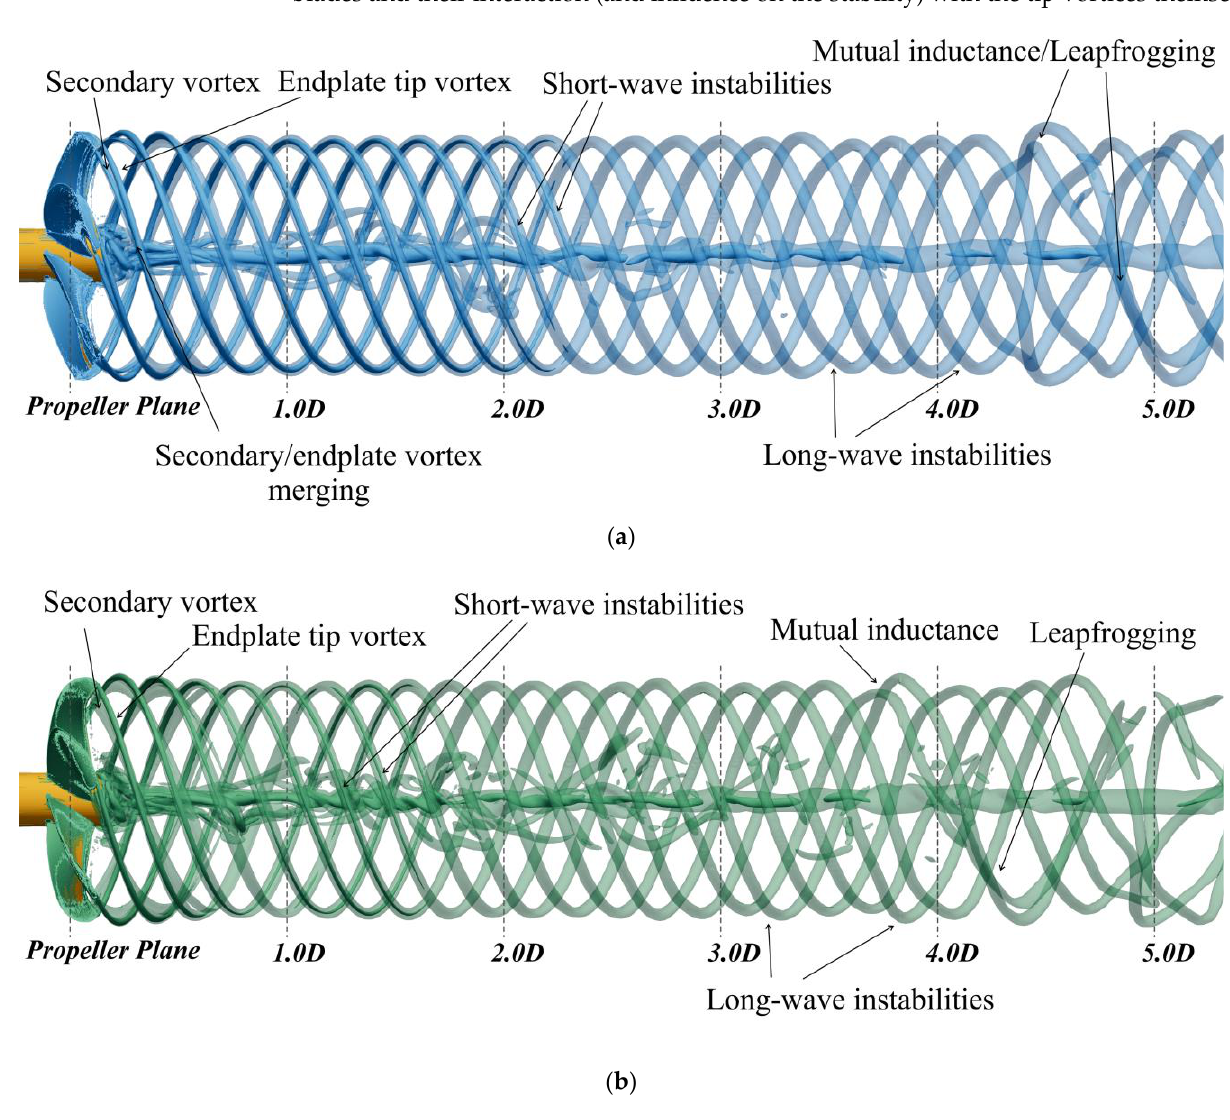
Figure 10. Isosurface of Q (5000 s −2 superimposed to Q = 50,000 s −2 ) at the design advance coefficient ( J = 0.9). General overview. ( a ) Conventional CLT propeller; ( b ) New generation CLT